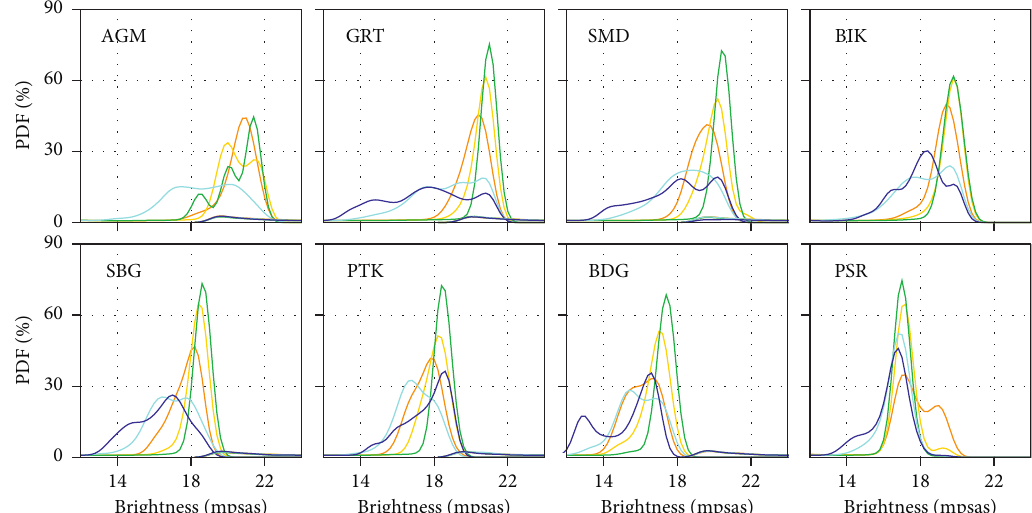
Figure 7: Distribution of sky brightness over different stations constructed from categorized data. The color code is similar to that in Figure